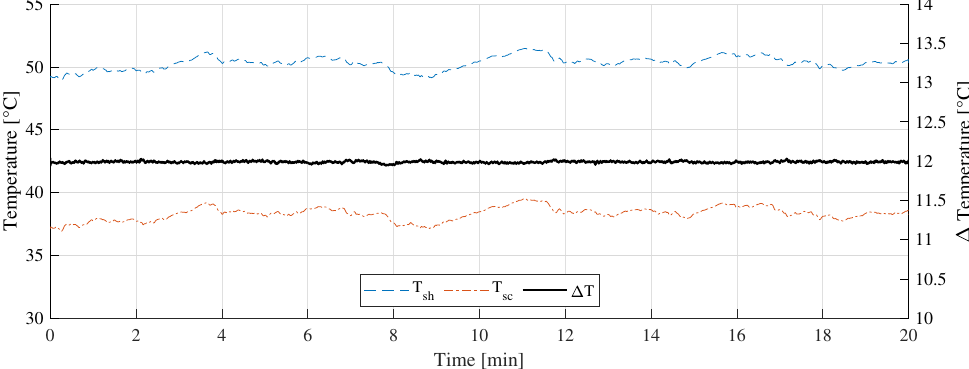
Figure 13. Temperature measurement during the A measurement. Figure 14 shows the “B” measurement taken on 14 February 2022 at 11:10 a.m. with partially cloudy conditions. During the experiments, cumulus and stratocumulus clouds were present. Figure 15 shows the measurement difference between the CTD prototype and the pyranometer in “B” measurement. The absolute error measured was 55 ± 45 W/m 2 . Figure 16 shows the temperatures of the hot sensor ( T sh ), cold sensor ( T sc ), and the temper- ature difference ( ∆ T ) during “B”